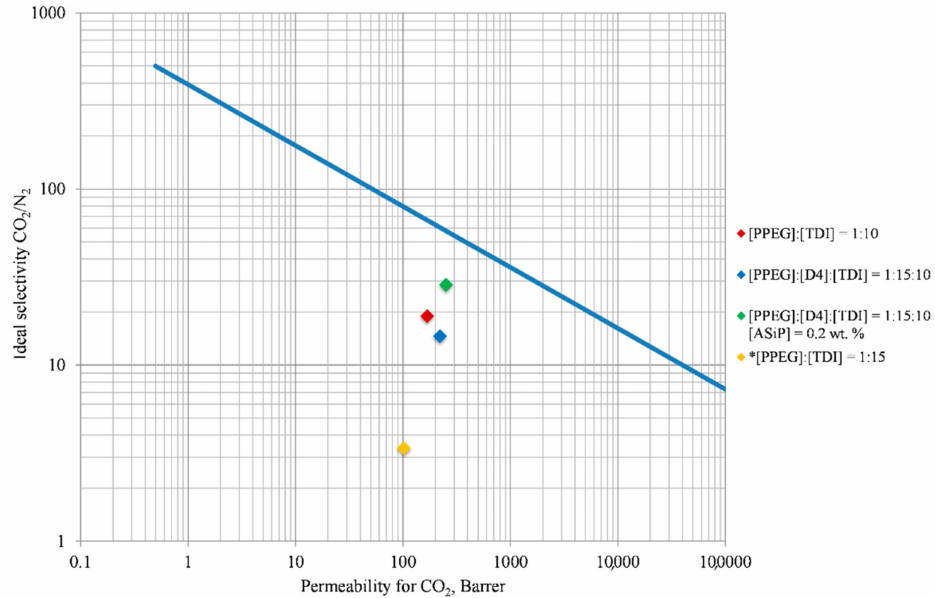
Figure 16. Upper bound correlation for CO 2 /N 2 separation.